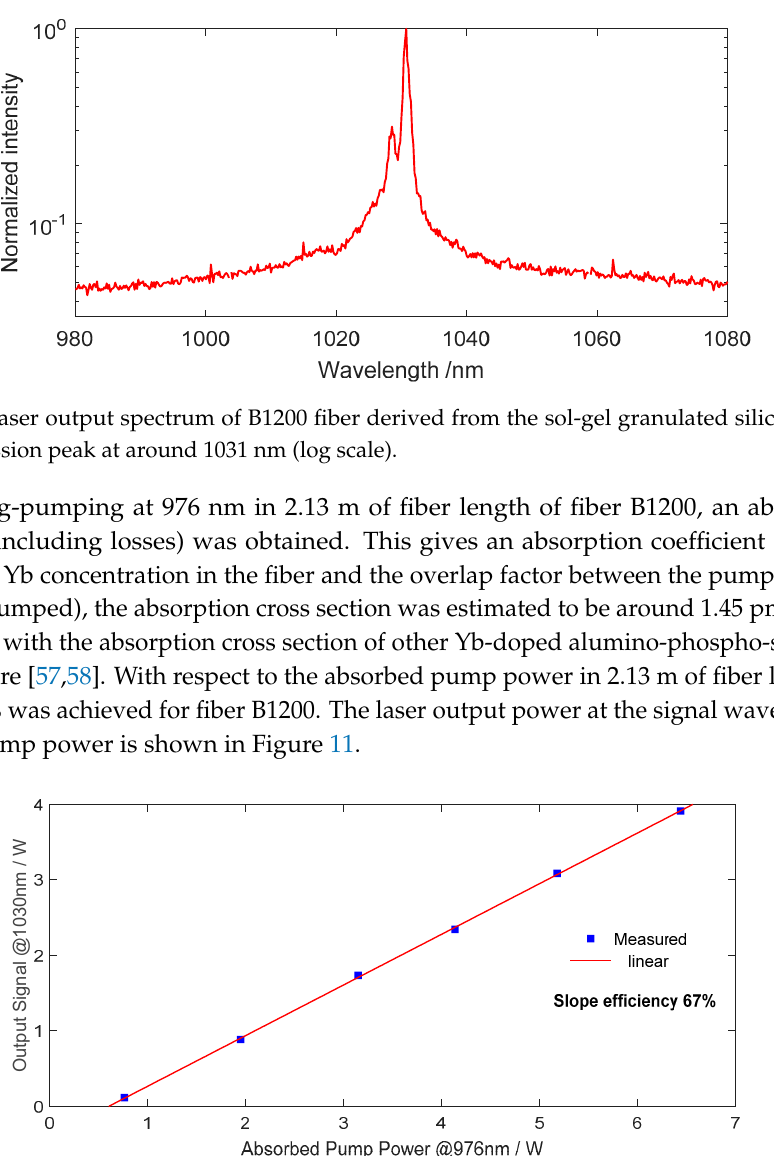
Figure 9. Yb-doped fiber (YDF) free-space laser arrangement, with fiber-pigtailed pump diode source, collimating and coupling lenses (L, L 1 , and L 2 ), in-coupling dichroic mirror (M 1 ), dichroic mirror (M 2 ), and a set of long pass filters centered at 1000 nm.